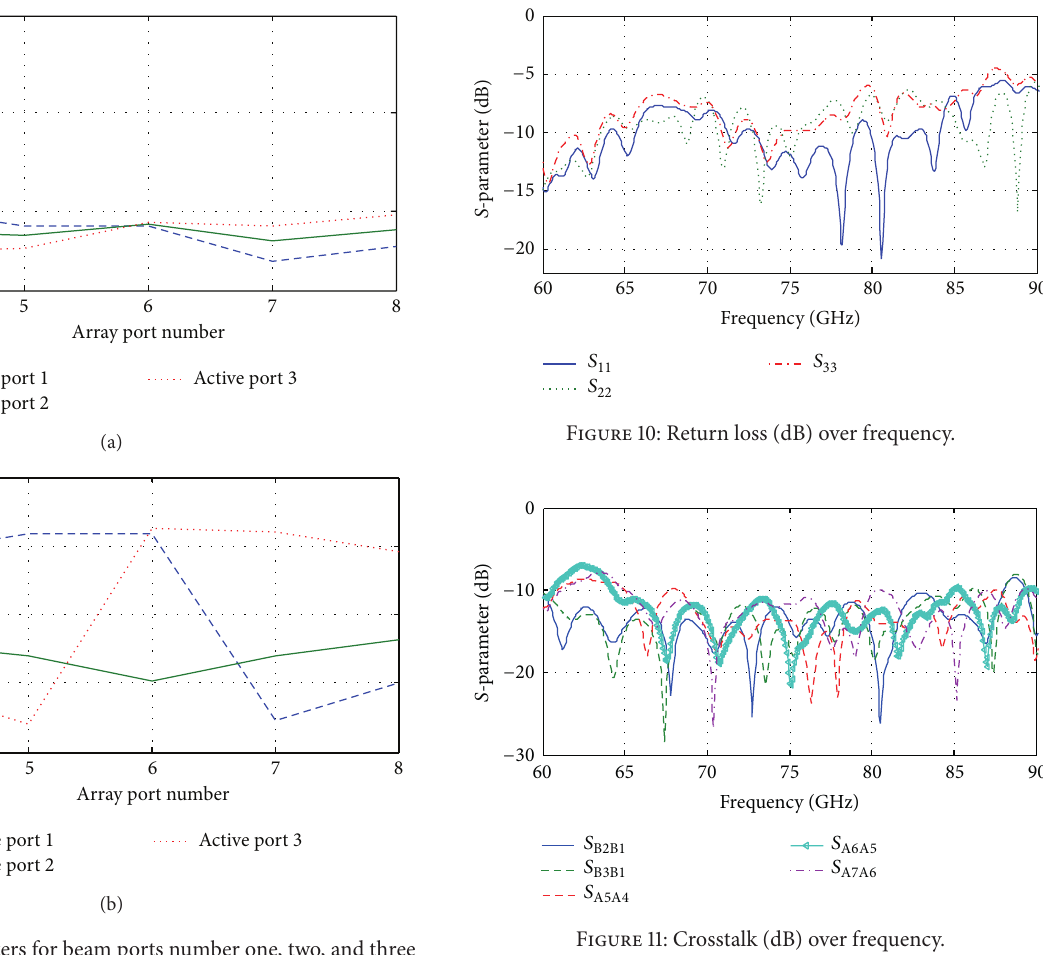
Figure 9: 𝑆 -parameters for beam ports number one, two, and three active, (a) magnitude, (b) phase.